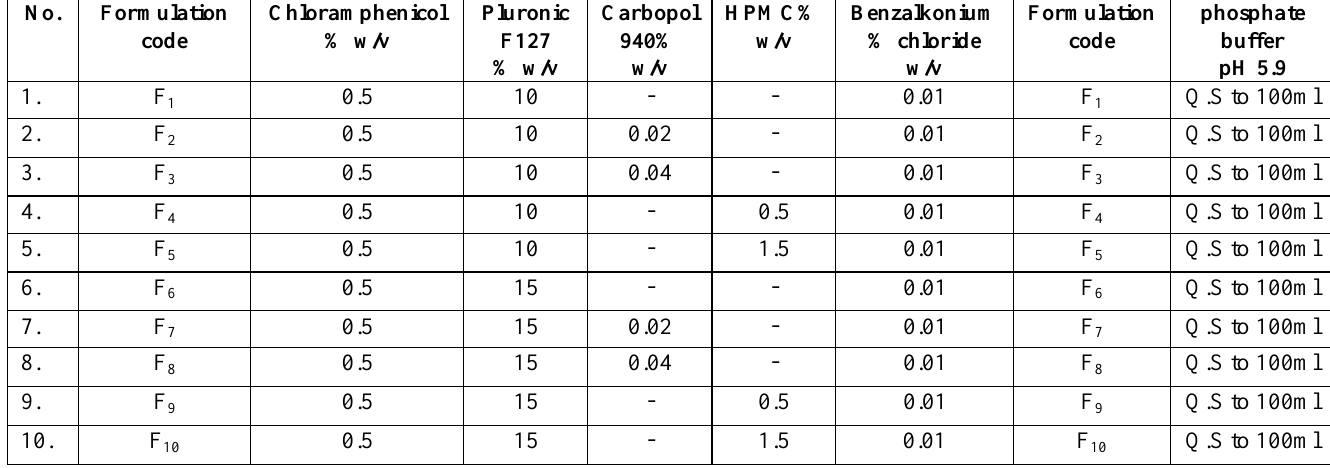
Table (1): Composition of different formulas in-situ gelling systems of chloramphenicol. No. Formulation